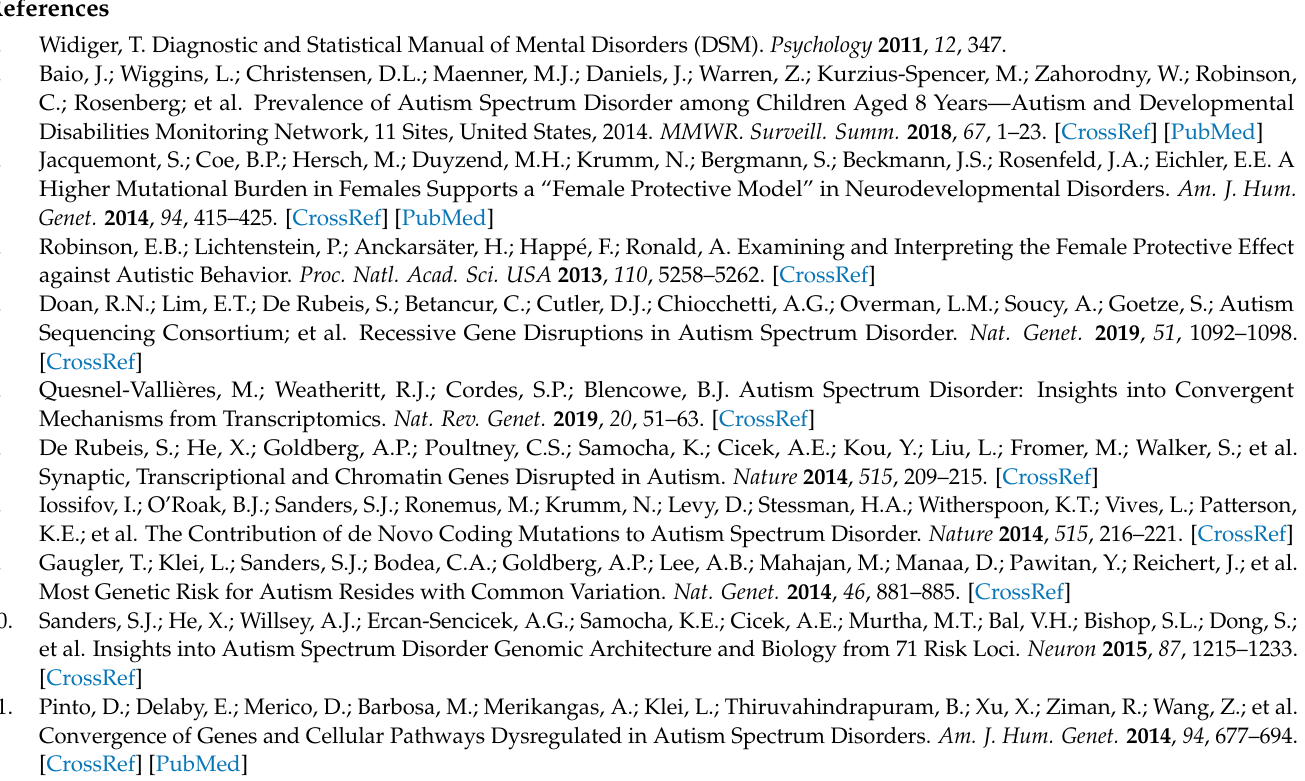
jumbled all together; Figure S3. Correlation (Pearson) matrix between estimated cell type proportions and PCs. Positive correlations are represented in red, while negative correlations are in blue. The cell type proportions correlate strongly with PC1; Figure S4. Cell type composition estimated by methylation data. Boxplots are used to visualize the cell type proportion by each disease group. We observed that the proportion of CD4T and CD8T were slightly higher than normal samples. Statistical significances of differences were tested by Wilcoxon test; Figure S5. QQ-plots showing the association test inflation levels. Upper panel, before adjust cell type proportion, inflation coefficient ranges 1.479–2.208. Lower panel, after adjust cell type proportion, inflation coefficient ranges 1.200–1.646. The QQ-plots showing that after adjustment of cell type proportion, inflation is